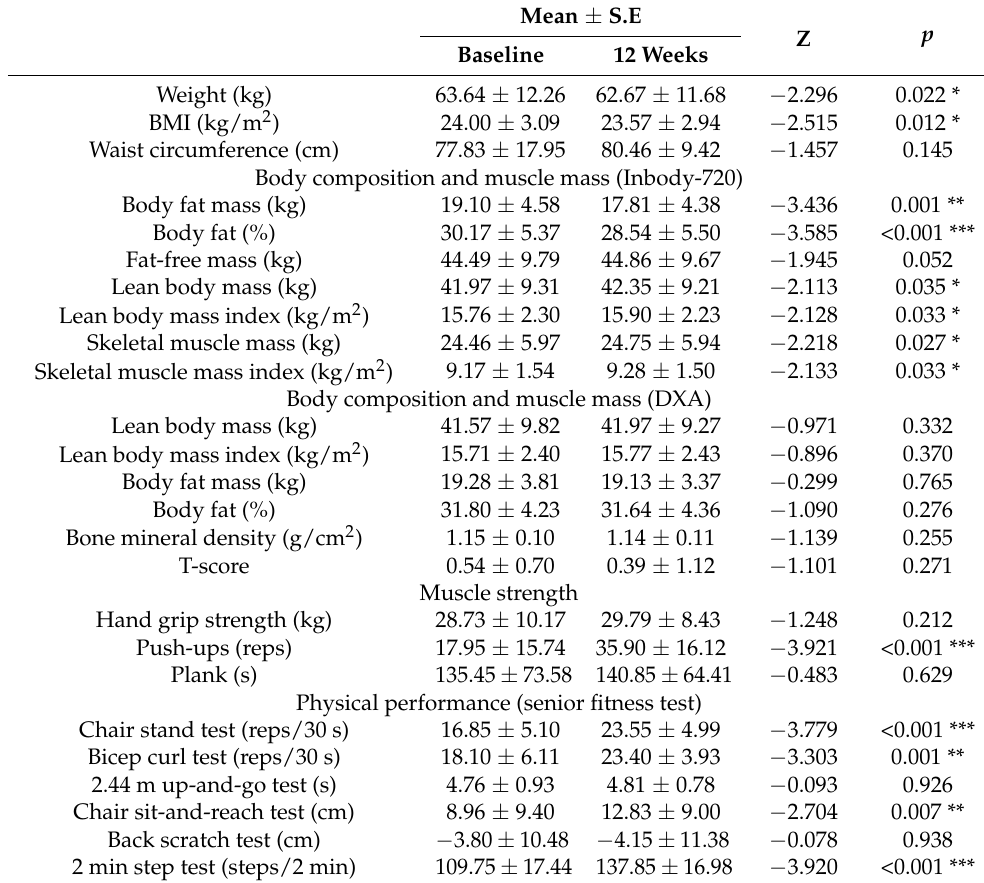
Table 6. Changes within the control group ( n = 20) during the 12-week study